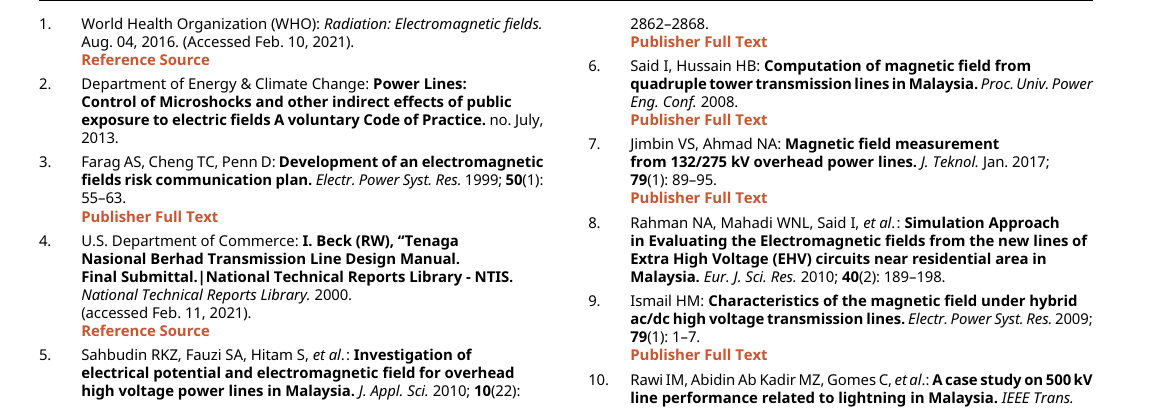
Figshare: Data for Electric and Magnetic Field of Power Transmission Lines in Malaysia. https://doi.org/10.6084/m9.figshare.16577423.v2. 20 The project contains the following underlying data: (cid:129) Data for Electric and Magnetic Field of Power Transmission Lines in Malaysia. (Simulated dataset of electric and magnetic field of five types of power transmission lines in Malaysia in Tables 1-12 and Figures 1-20). (cid:129) Figure 1. (Overhead power transmission lines towers in Malaysia). (cid:129) Figure 2. (Overall project flow). (cid:129) Figure 3. (Geometrical illustration for the magnetic and electric field calculation). (cid:129) Figure 4. (Double circuit phase configuration for standard transposed phasing (left) and un-transposed phasing (right). (cid:129) Figure 5. (Quadruple circuit phase configuration for standard transposed phasing (left) and un-transposed phasing